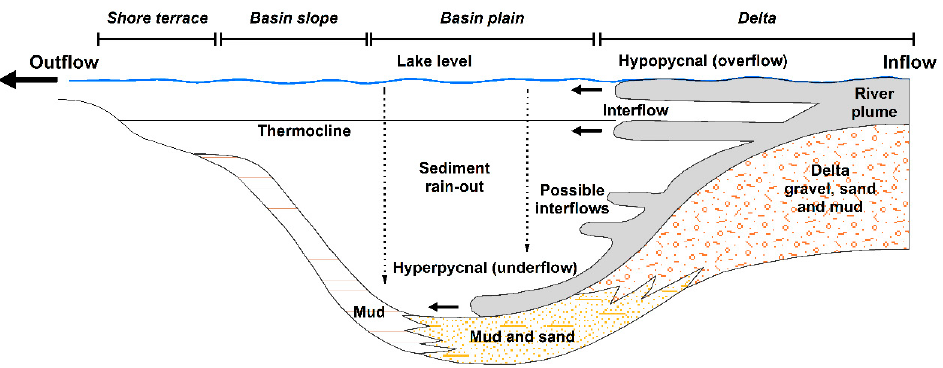
Figure 9. Conceptual model of sediment dispersal and associated deposits within a lake basin dominated by clastic sedimentation. Figure not to scale, modified from [30].